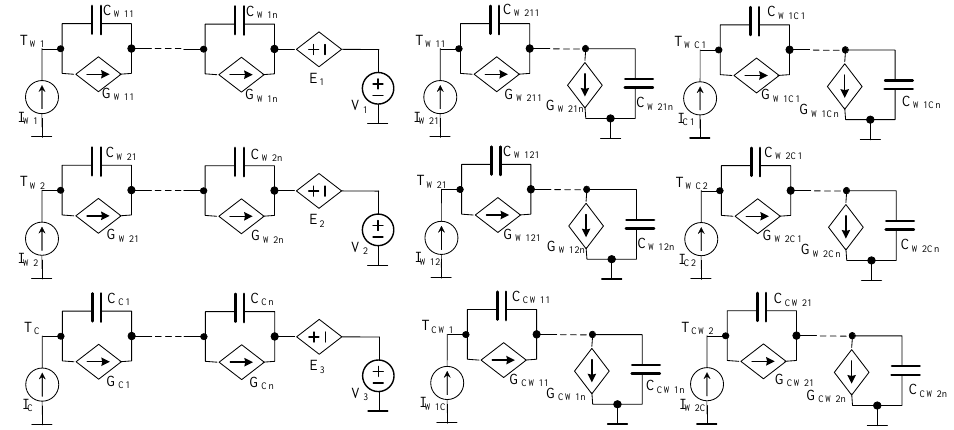
Figure 4. Network representation of a compact nonlinear thermal model (CNTM) of a pulse transformer.